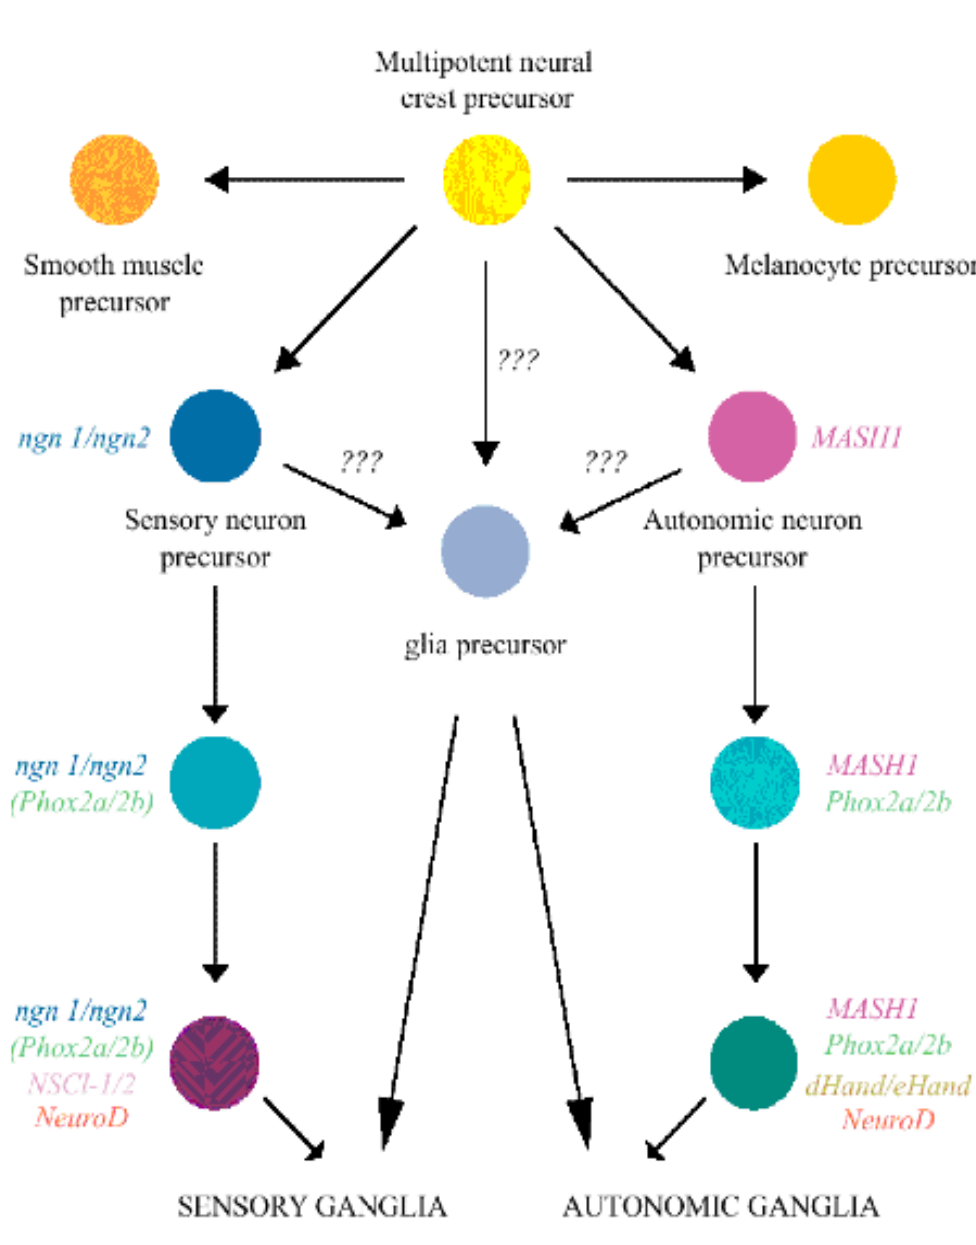
FIGURE 4. The formation of the autonomic and sensory ganglia from the neural crest. Multipotent neural crest precursors may adopt different fates. Precursor cells fated to generate sensory neurons express ngn genes; precursors fated to generate autonomic neurons express MASH1. They subsequently express other transcriptions factors such as Phox2a/2b (cells that will show a noradrenergic phenotype, i.e., all the MASH1- and a subset of the ngn-expressing precursors), NSCL1/2 (sensory neurons), dHand/eHand (autonomic neurons), and NeuroD (both types). These neurons contribute together with glial cells to the autonomic or sensory ganglia. Glial cells originate from glial precursors whose origin is uncertain; they may form a distinct subpopulation of precursors or may arise from sensory and autonomic neuron precursors (see text for details and